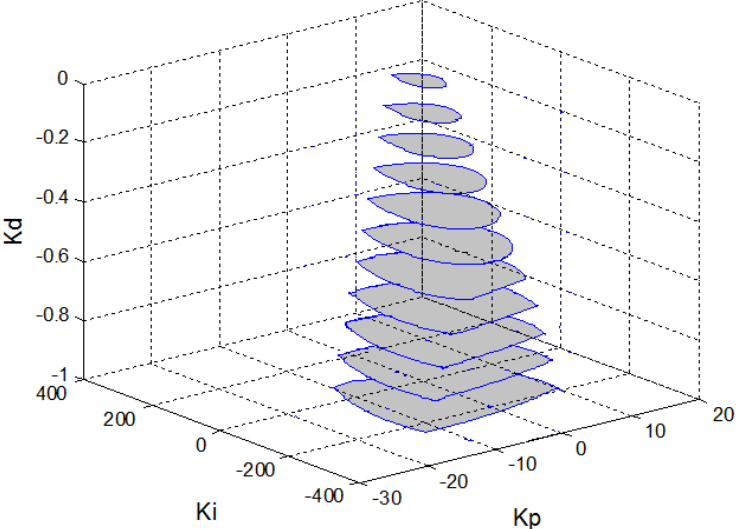
k k − − parameter space for Equation p